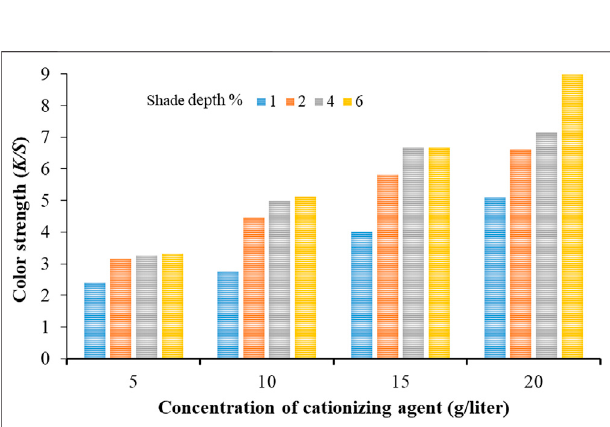
FIGURE 6 | Comparing the color strength ( K/S ) values obtained by increment in the concentration of cationizing agent and shade depth (%)